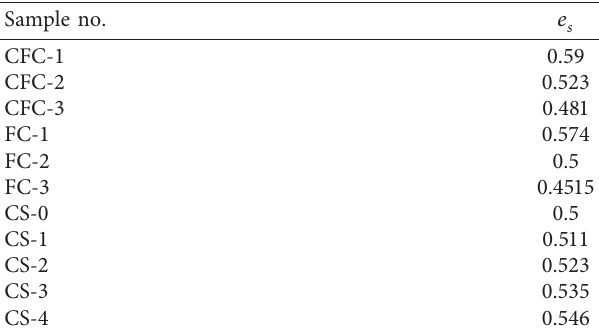
Figure 6: Comparison between clean gravel and clay-sand-gravel mixture. (a) Schematic diagram of clean gravel and clay-sand-gravel mixture. (b) Image of gravel without clay. (c) Image of gravel with clay. Table 4: Intergranular porosity ratio of each